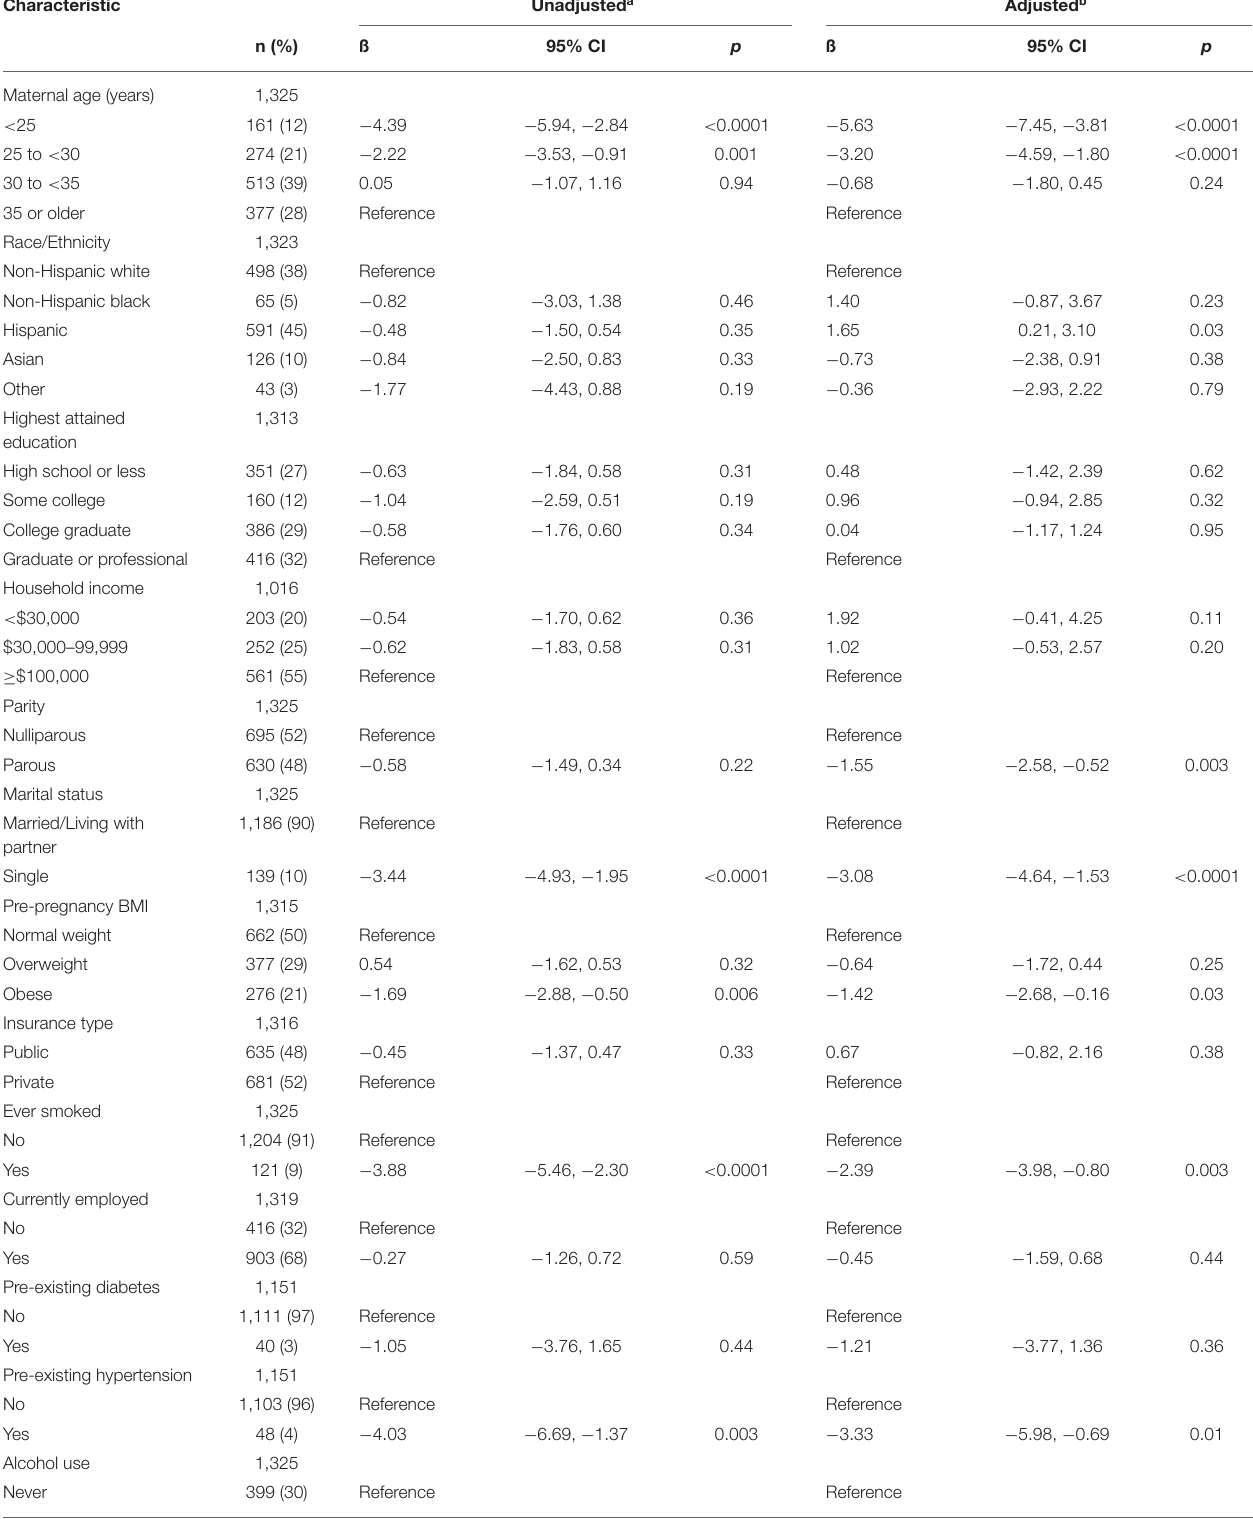
TABLE 2 | Unadjusted and multivariable linear regression analyses estimating associations of selected maternal characteristics and total Healthy Eating Index-2015 scores among pregnant women in the New York University Children’s Health and Environment Study. Characteristic Unadjusted a Adjusted